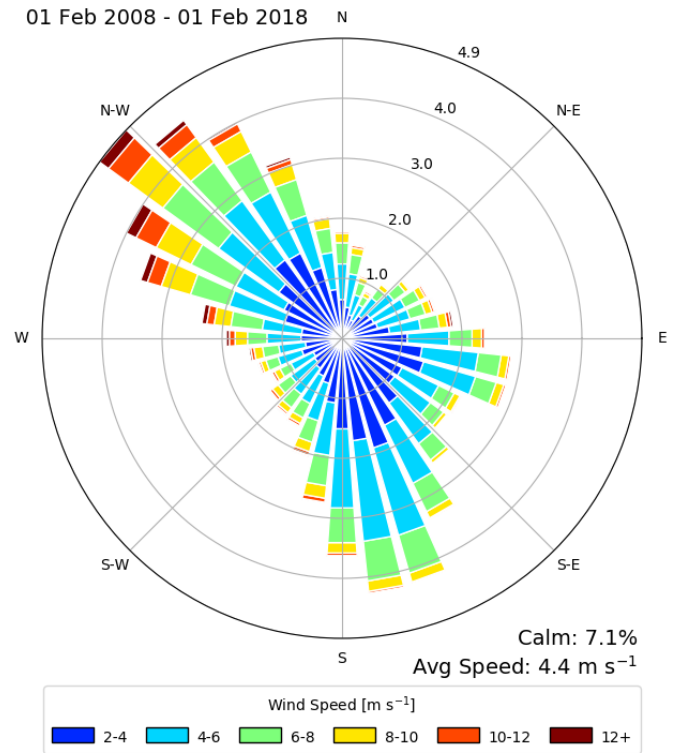
Figure 3. Wind rose measured at the Eastern Iowa Airport for 10 years, situated approximately 5 km to the SW of the wind turbine and visible in Figure 2. The wind presents two main directions: NW and SSE. Data obtained from Iowa State University, Iowa Environmental Mesonet. The length of the bars indicate frequency in percentage